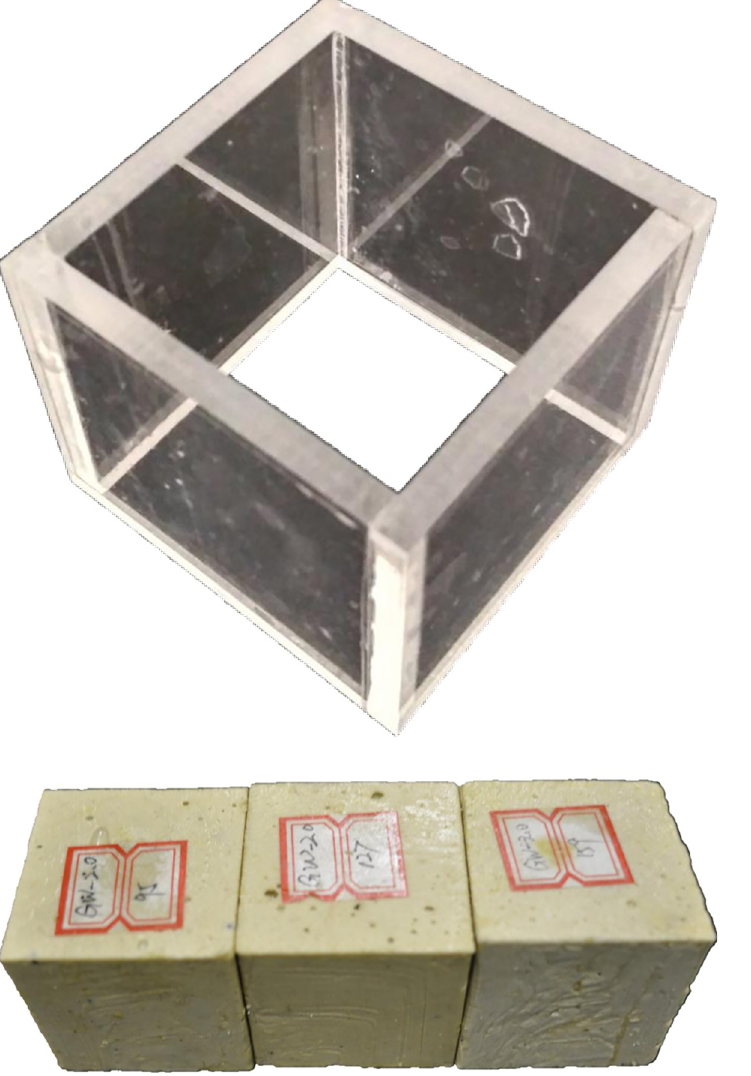
Fig 5. Compressive and shear